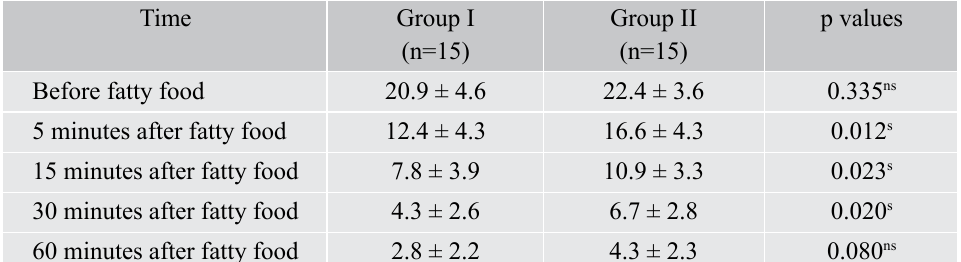
Table II: Mean comparison of effect of fatty food on gallbladder volumes (in cm 3 ) between two groups (n=30)